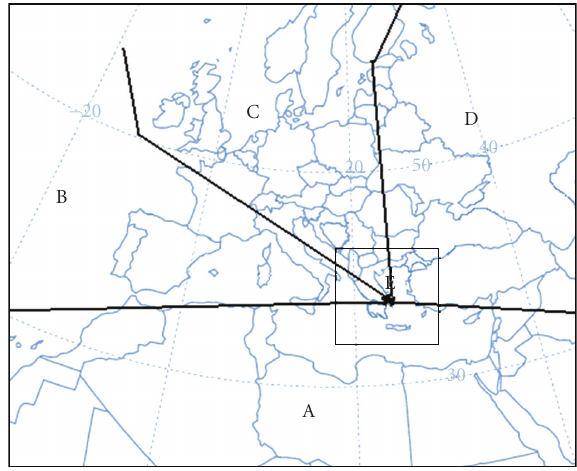
Figure 1: Separation of the regions acting as origins for the air masses ending at GAA. The location of GAA is indicated by an asterisk.